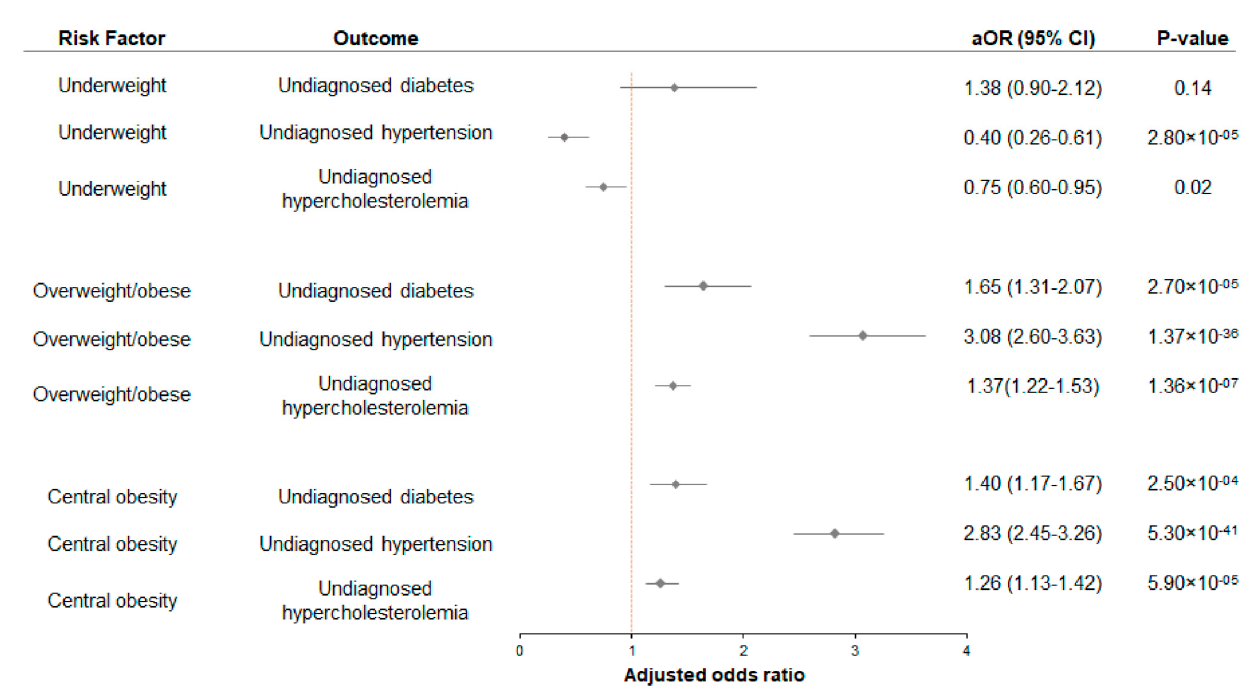
Figure 3. Associations between general obesity and central adiposity with undiagnosed diabetes mellitus, undiagnosed high blood pressure, and undiagnosed hypercholesterolemia in Malaysian adults aged 18 years and above. Multiple logistic regression was performed, and adjusted for sociodemographic (i.e., sex, age, ethnicity, residential area, marital status, educational level, household monthly income) and lifestyle risk factors (i.e., adequate fruit and vegetable intake, alcohol intake, smoking status, physical activity). There were no significant interactions among the independent variables. aOR: adjusted odds ratio; 95% CI: 95% confidence